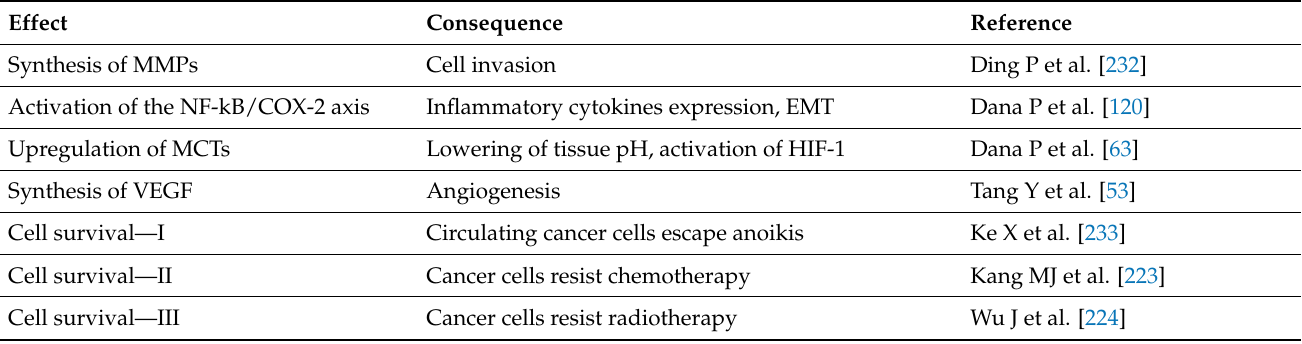
Table 3. Effects directly resulting from AKT activation promoted by CD147